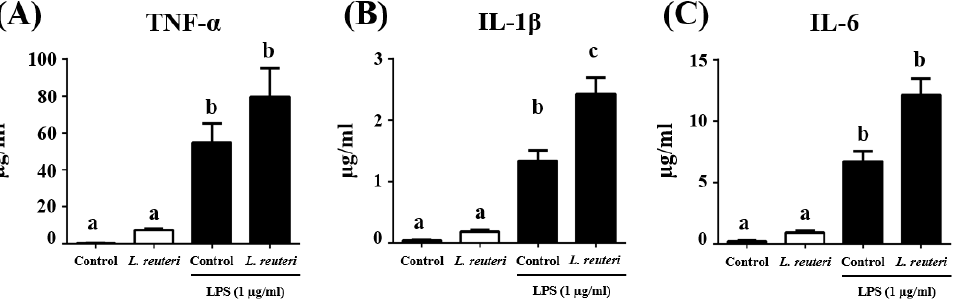
Figure 1. Data represent the mean ± standard deviation of at least three separate experiments. ( A ) NO production (µM) in a RAW 264.7 cell line upon stimulation with lipopolysacharides (LPS) (0.01, 0.1, and 1 µg/mL) or L. reuteri INIA P572. ( B ) Nitric Oxide (NO) production (%) of RAW 264.7 cells stimulated only with 1 µg/mL LPS (considered 100%) or previously activated with L. reuteri INIA P572. Different samples with different letters (a-c) show significant differences ( p < 0.05).